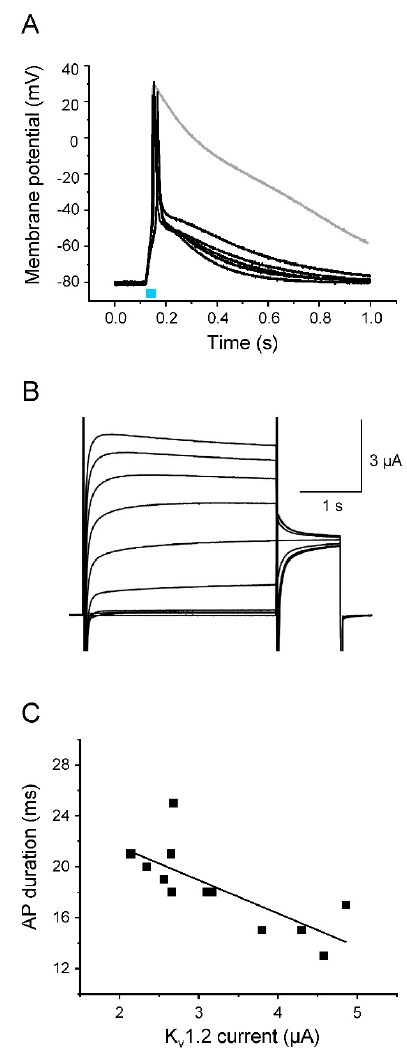
Figure 5. Acceleration of AP repolarization by K v 1.2. ( A ) Representative light-induced APs from 5 different oocytes co-expressing Na v 1.5-CC-2 and K v 1.2. The 30 ms-light pulse is illustrated as a blue bar. The gray line represents a control AP from an oocyte injected with Na v 1.5 ‐ CC ‐ 2 cRNA only. For detailed statistics on AP parameters, see Table 3. Peak current values and oocyte features are summarized in “Supplementary Materials” (Table S1). ( B ) Corresponding K v 1.2 currents elicited by a first test pulse between − 50 mV and +40 mV in 10 mV increments, followed by a second test pulse